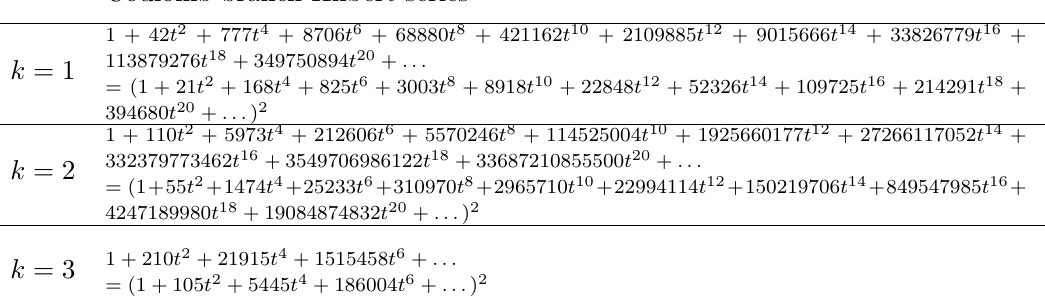
Table 13. Hilbert series results for (2.21). The first line displays the Coulomb branch Hilbert series for (2.21), while the second line displays the factorisation into a product. Each factor agrees with the known Hilbert series.